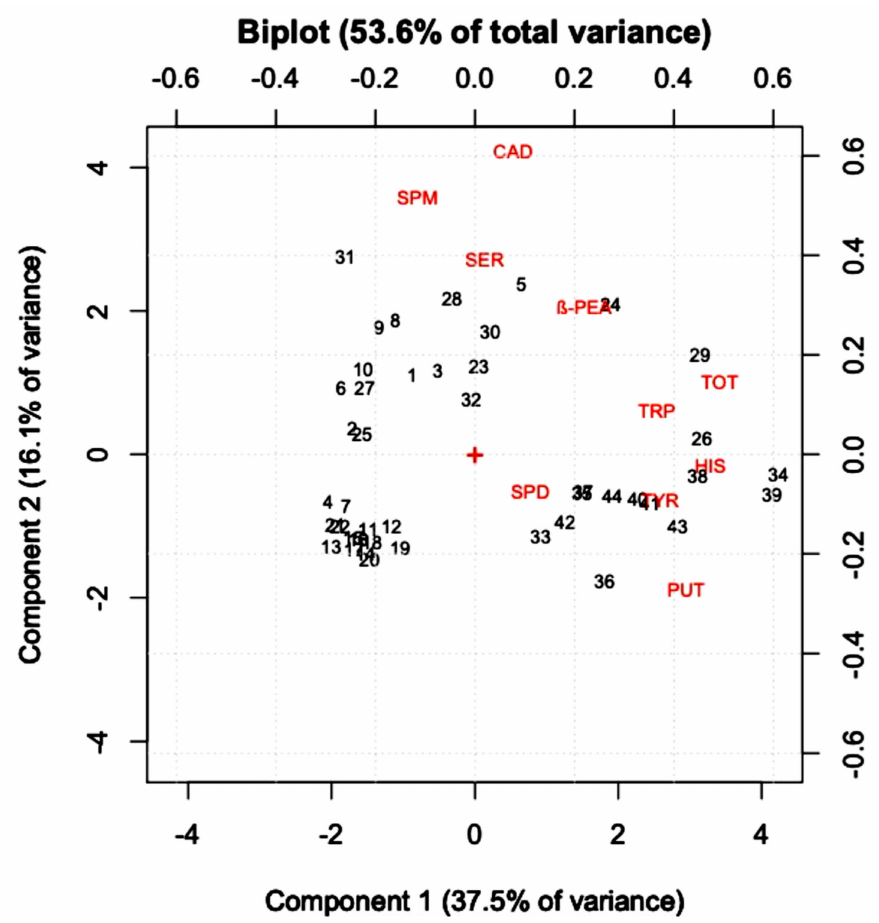
Figure 4. Biplot of white and red wines of Italian